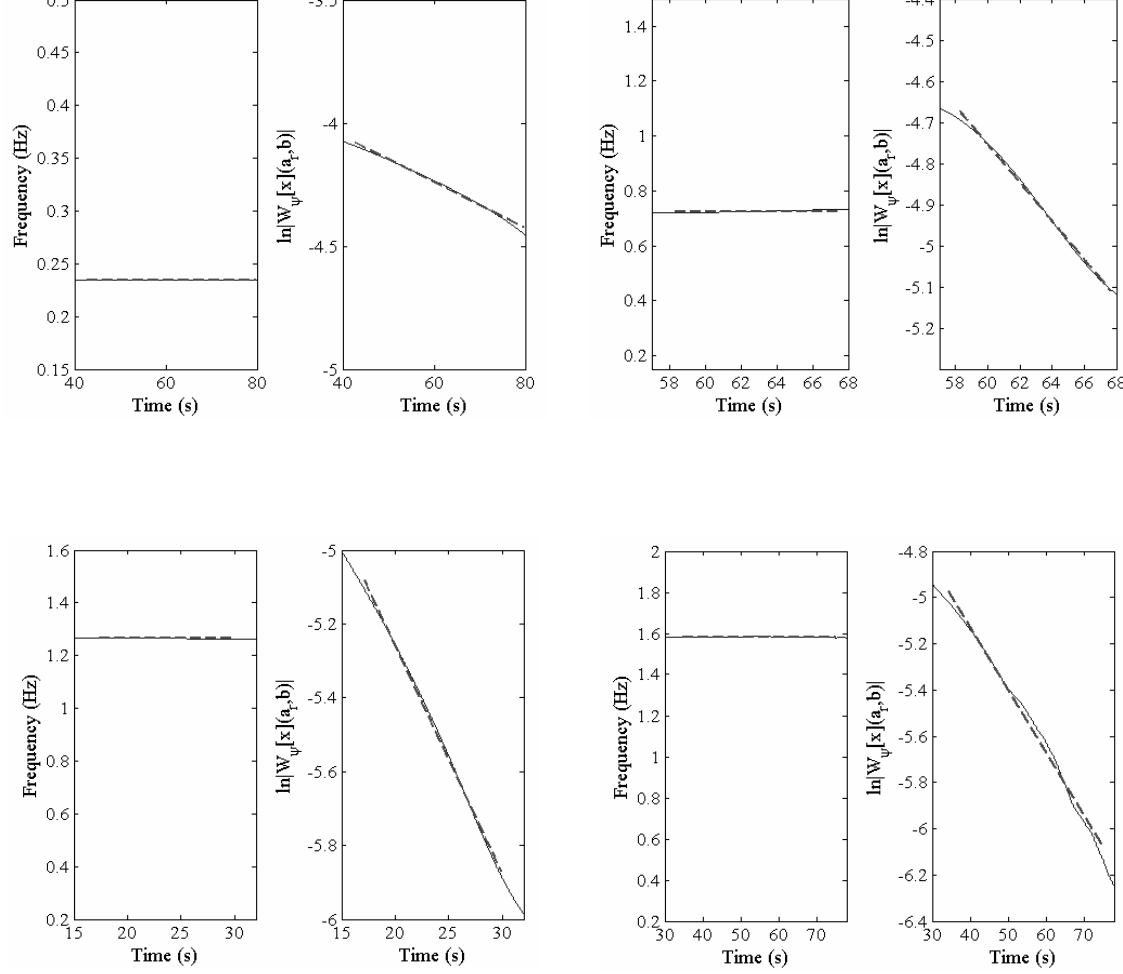
Fig. 4. Instantaneous frequencies and wavelet transform envelopes for the first four modes Measured (——) and identified